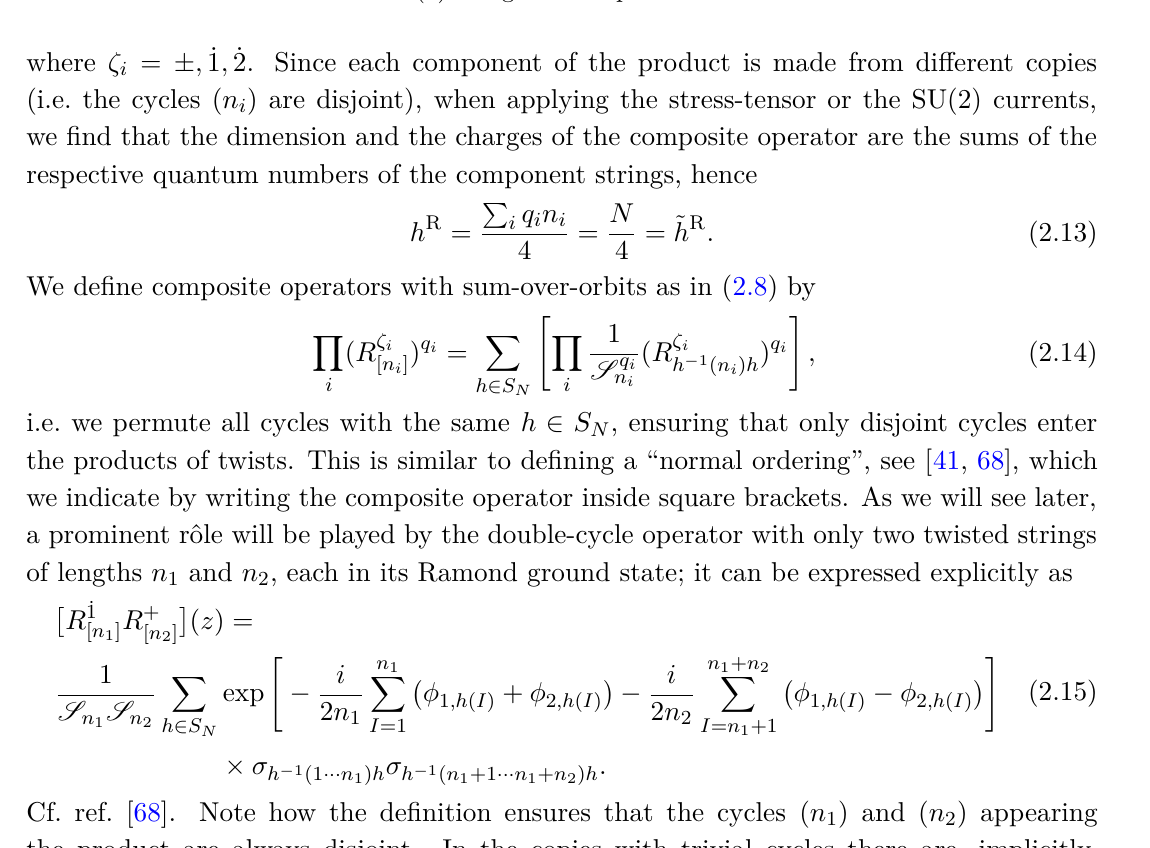
Table 2 . SU(2) charges of composite Ramond